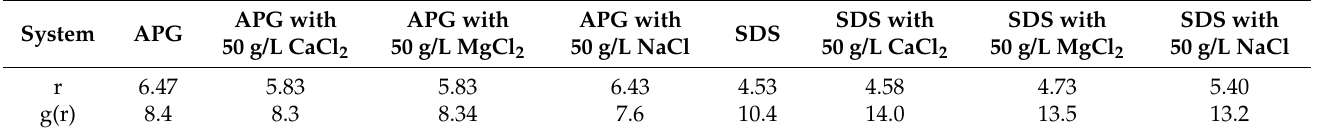
Figure 15. The RDF of head groups and head groups in different foams. ( a ) APG foam system, ( b ) SDS foam system. Table 3. Coordinate of peak value in different